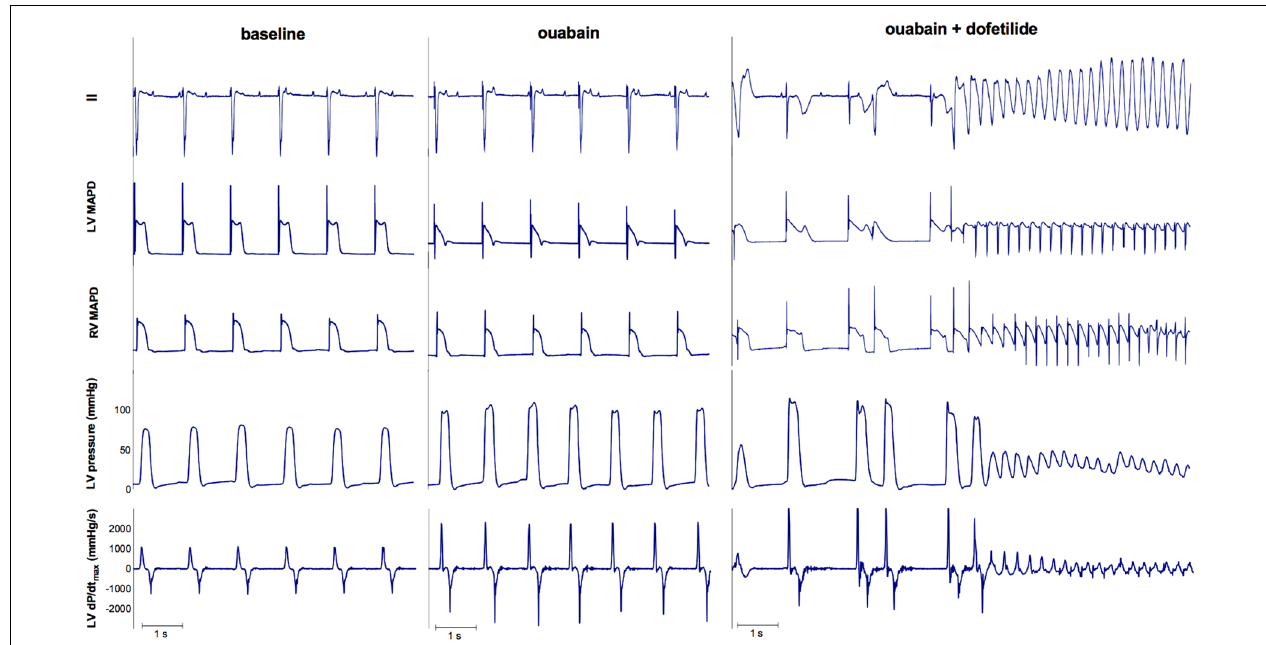
FIGURE 7 | ECG, LV MAP, RV MAP, LV pressure, and LV dP/dt max of dog 4. Administration of ouabain did not cause any arrhythmias. However, the combination of ouabain and dofetilide resulted in Torsade de Pointes